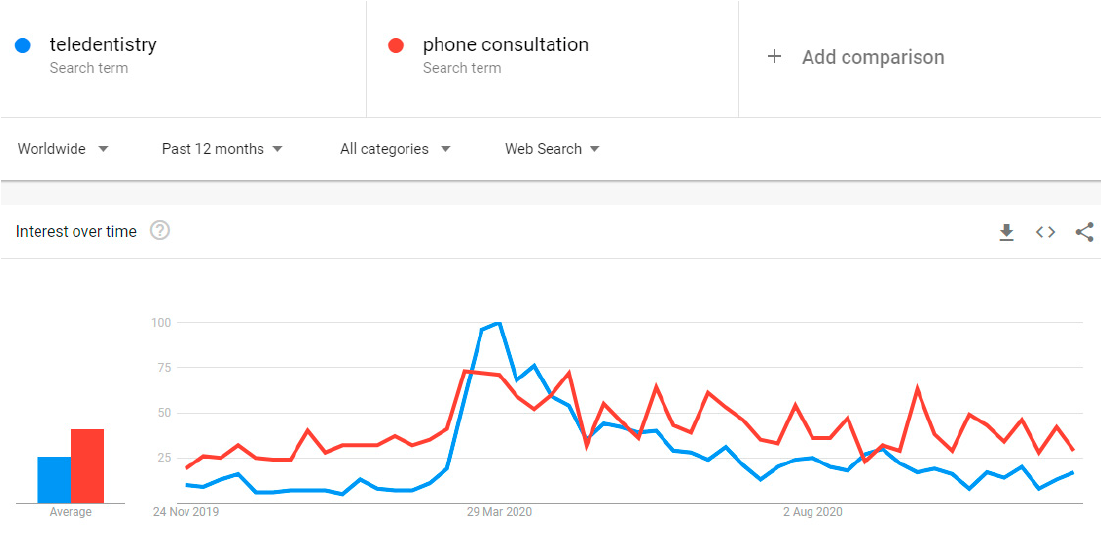
Figure 1. The worldwide online searching of terms ‘teledentistry’ and ‘phone consultation’ (Google Trends, accessed 14/11/2020) over the last 12 months.